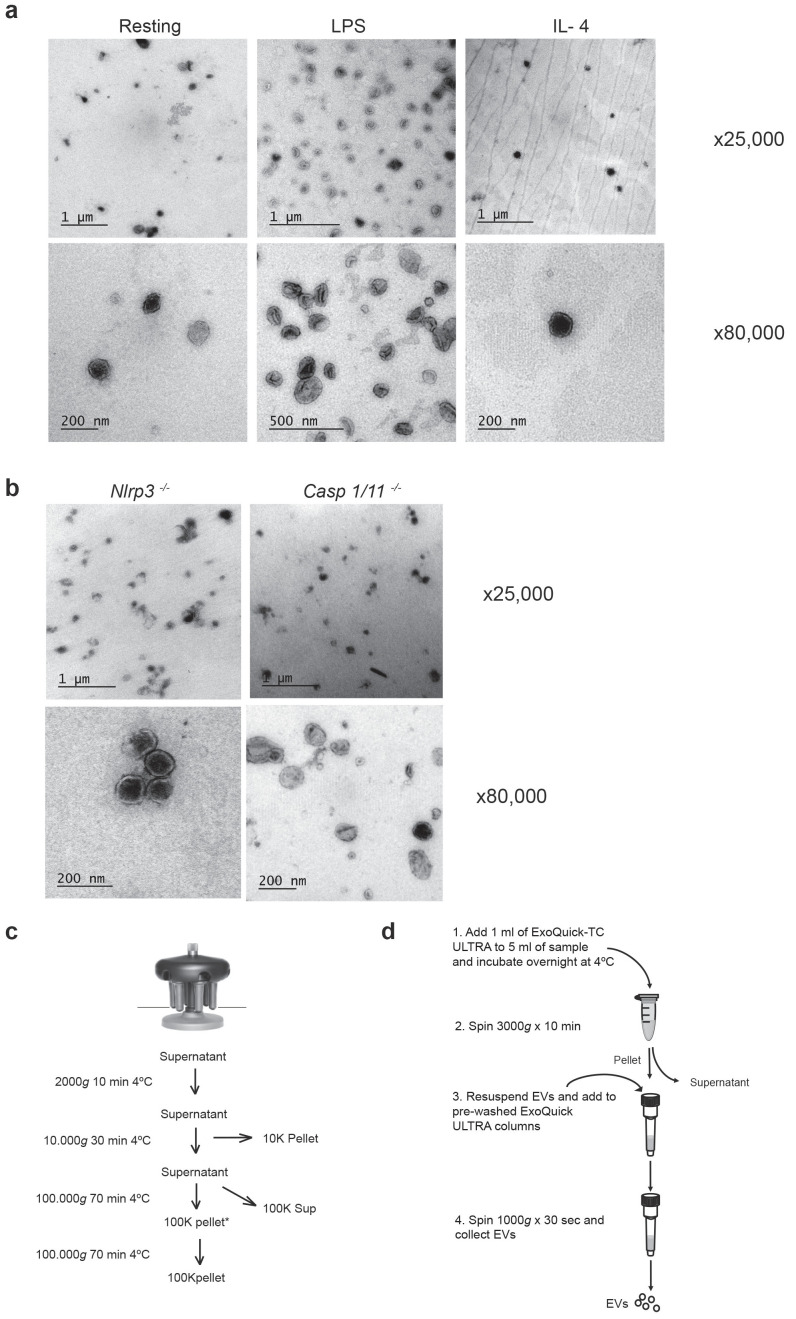
Electron microscopy of P2X7 receptor-induced extracellular vesicles.(a) Representative transmission electron microscopy images obtained from extracellular vesicle fraction isolated from cell-free supernatants of BMDM untreated (resting) or primed for 4 hr with LPS (10 ng/ml) or IL-4 (20 ng/ml) and then stimulated during 20 min with ATP (3 mM). Representative images from n ≥ 3 independent experiments. (b) Representative transmission electron microscopy images obtained from 100K pellet fraction obtained from cell-free supernatant of Casp1/11−/− and Nlrp3−/− BMDM primed for 4 hr with LPS (10 ng/ml) and then stimulated during 20 min with ATP (3 mM). Representative images of n = 3 independent experiments. (c) Diagram for extracellular vesicle isolation protocol based on differential centrifugation. Speed, duration, and temperature of each centrifugation step are indicated. Pellets are discarded after first two centrifugations and the supernatant is kept for the next step. In the last 100,000 xg centrifugation, 100K pellet fraction is obtained. (d) Diagram for extracellular vesicle isolation protocol based on Exo-Quick kit.